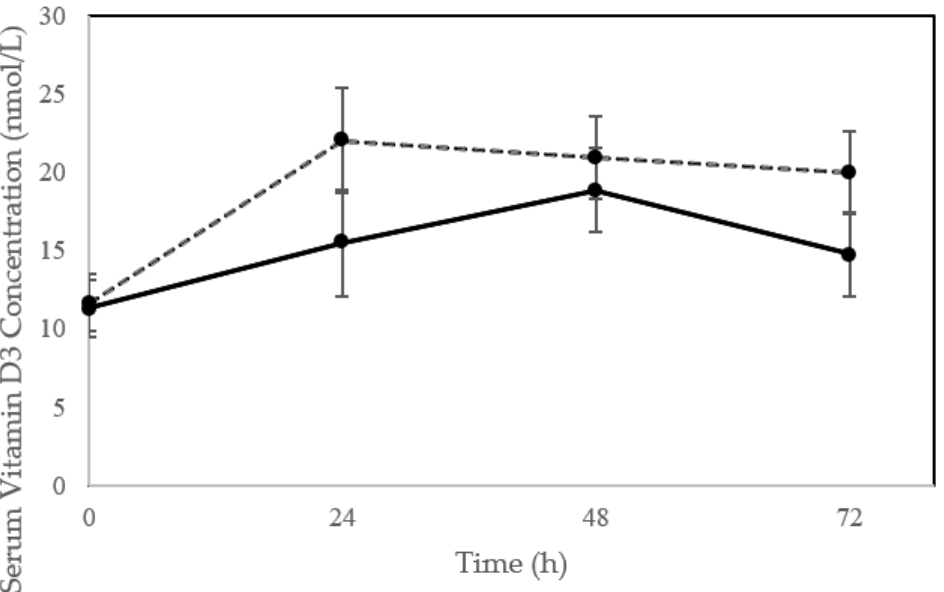
Figure 1. Vitamin D 3 concentration following a single bout of sun exposure (time 0) in older (solid line) compared to younger (dashed lines) adults. Serum vitamin D 3 concentration increased significantly post exposure (time effect; p < 0.002) with a trend for a difference in vitamin D 3 response between older and younger individuals (time*group; p = 0.09). Error bars represent ± SE. Despite changes in serum vitamin D 3 concentration, serum 25(OH)D concentration did not change following sunlight exposure and was not different between baseline and 72 h ( p = 0.561) or baseline and 168 h post exposure ( p = 0.237) (Figure 2).